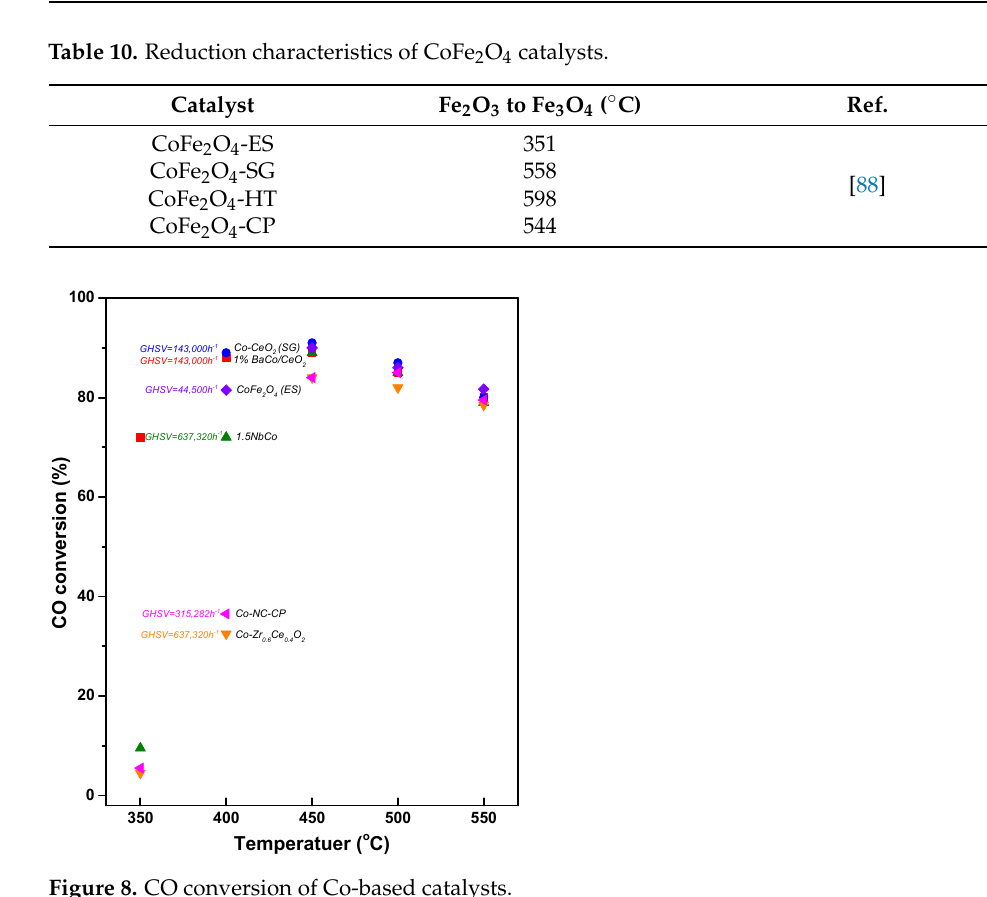
Figure 8. CO conversion of Co-based catalysts. Table 8. Characteristics of Co-based catalysts.